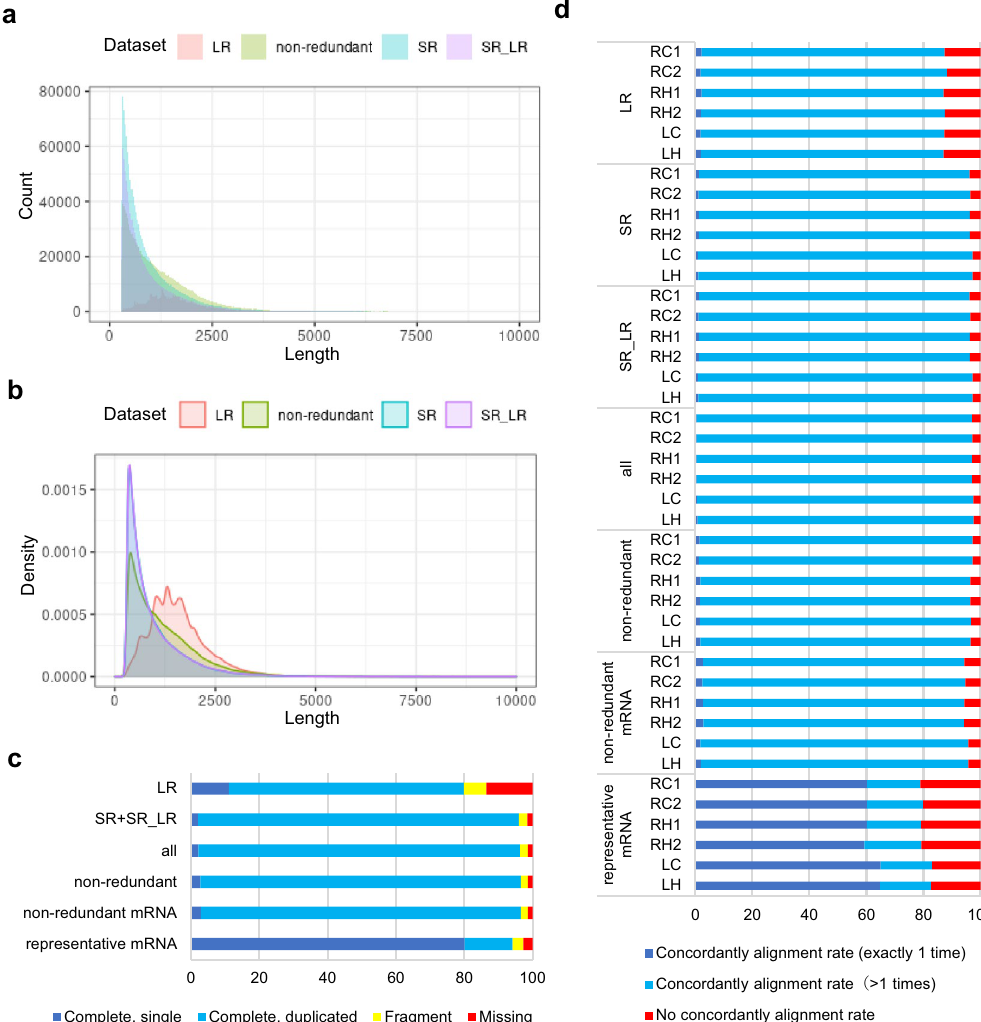
Figure 3. Comparison of long-read and short-read derived datasets and their combined non-redundant transcript dataset in the aspect of sequence length, completeness, and mapping rate. ( a , b ) Nucleotide lengths in each dataset was indicated using histogram ( a ) and density plot ( b ). ( c ) Result of the BUSCO assessment of each dataset on Embryophyta data. ( d ) Alignment rate of each short-read sequence toward the combined dataset using the Bowtie2 aligner. LR: long-read derived sequences including L1 and LS dataset. SR: short-read-derived dataset including RC1, RC2, RH1, RH2, LC, and LH datasets. SR_LR: short-read- and long-read-derived dataset including RC1_LR, RC2_LR, RH1_LR and RH2_LR. RC1: short-read sequences from ray florets under control conditions, stage 1. RC2: short-read sequences from ray florets under control conditions, stage 3. RH1: short- read sequences from ray florets grown at the high nighttime temperature, stage 1. RH2: short-read sequences from ray florets grown at the high nighttime temperature, stage 3. LC: short-read sequences from leaves grown under control conditions. LH: short-read sequences from leaves grown at the high nighttime temperature. The growth stages of the ray-floret samples are indicated in Fig.